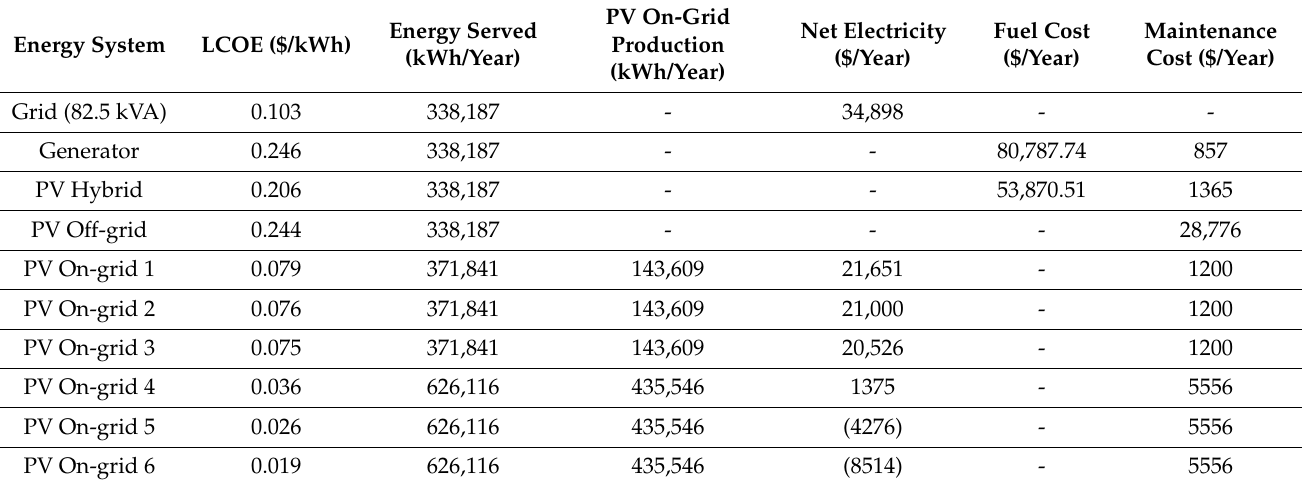
Table 6. LCOE Results of Energy